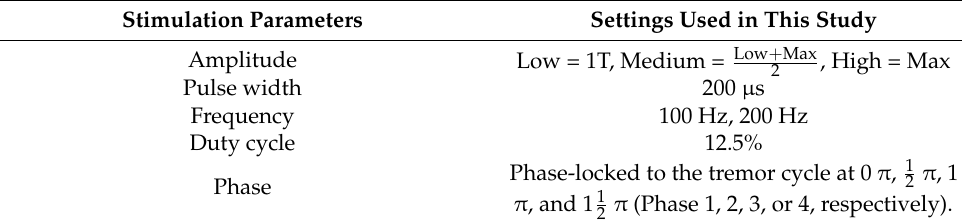
Table 2. Stimulation parameters and their ranges. Stimulation Parameters Settings Used in This Study